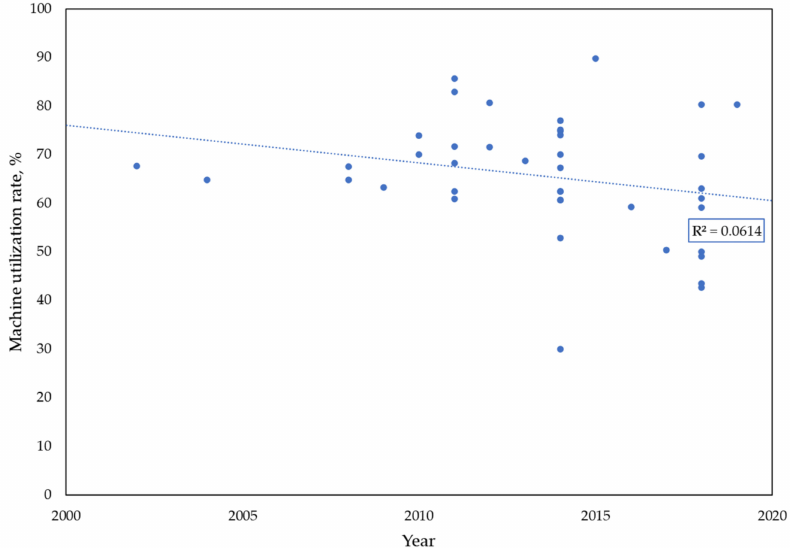
Figure 10. Changes in the machine utilization rate during the 20 years from 2000 to 2020,